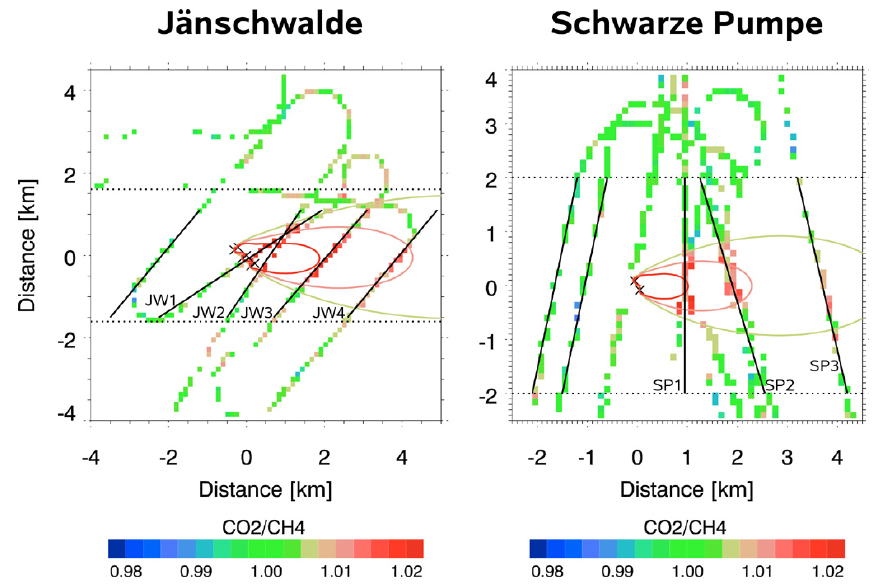
Fig. 3. The figures show the MAMAP data for power plants J¨anschwalde and Schwarze Pumpe rotated and bent (only Schwarze Pumpe) to wind direction. The solid black lines (JW1, JW2, ... and SP1, ...) indicate boundaries used for the Gaussian integral inversion whereas the contour lines show the fit result of the Gaussian plume model inversion. The dashed black lines show the area which has been taken into account for the Gaussian plume